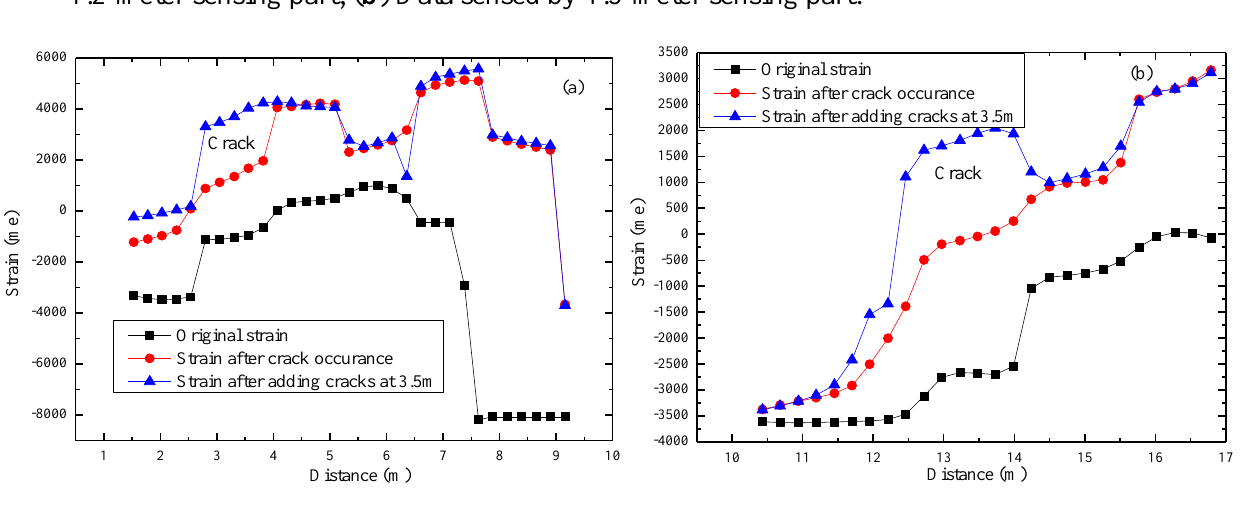
Figure 15. Strain detected by the proposed sensor along the span. ( a ) Data sensed by 1.2-meter sensing part; ( b ) Data sensed by 1.5-meter sensing